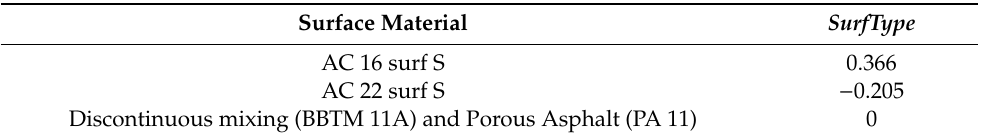
Table 11. Values of the variable SurfType in Equation